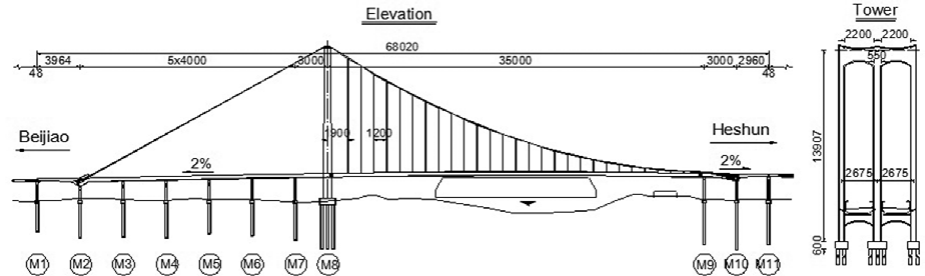
Fig. 1. General layout of Pingsheng bridge, Table 1. Main structural design parameters of the Pingsheng Bridge Member Steel girder